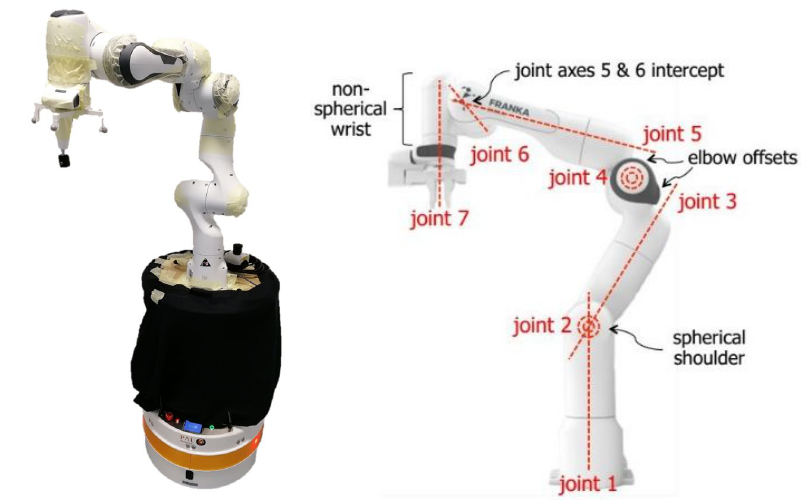
Figure 4. Mobile manipulator with Emika Franka Panda robot manipulator and Pal Tiago base.